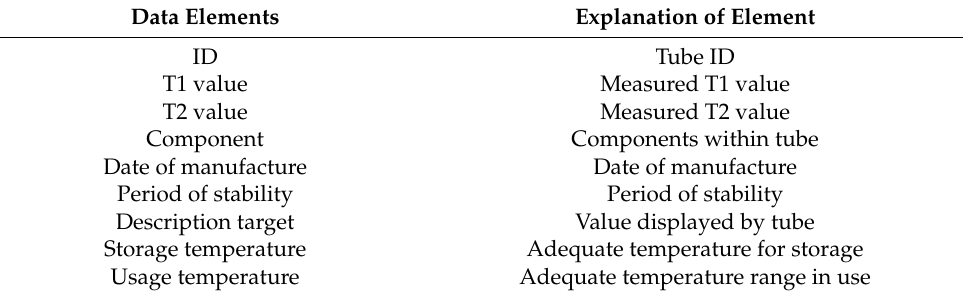
Table 4. Tube data model elements and explanation.